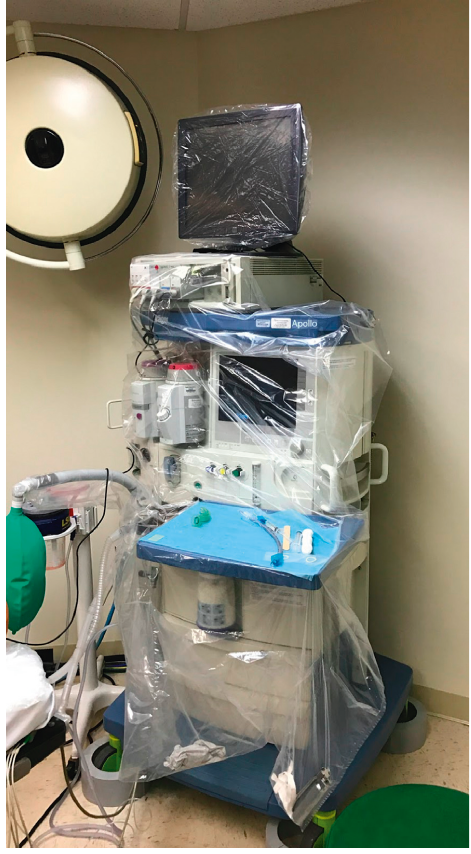
Figure 1: AMW displayed on a functioning